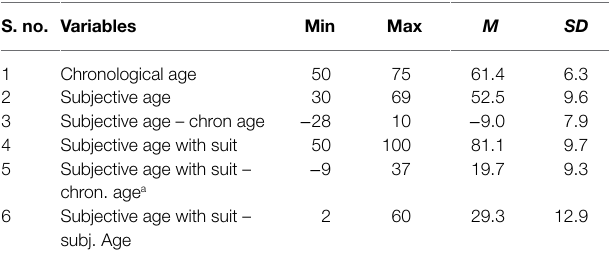
TABLE 2 | Age measures and effect of the age simulation